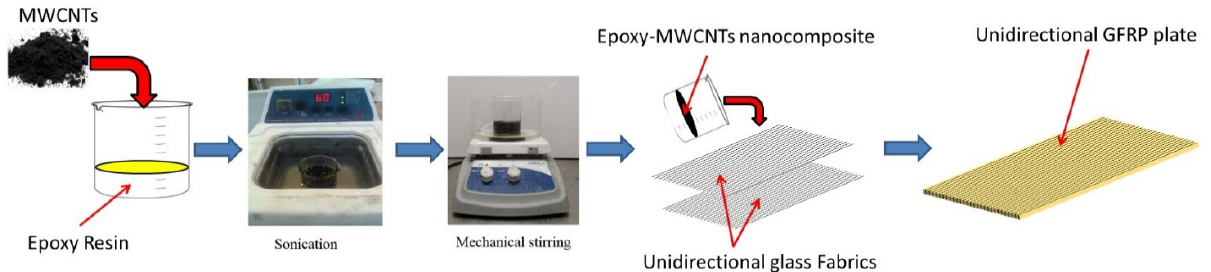
Figure 1. Schematic diagram for preparation of Multi-Wall Carbon Nanotubes